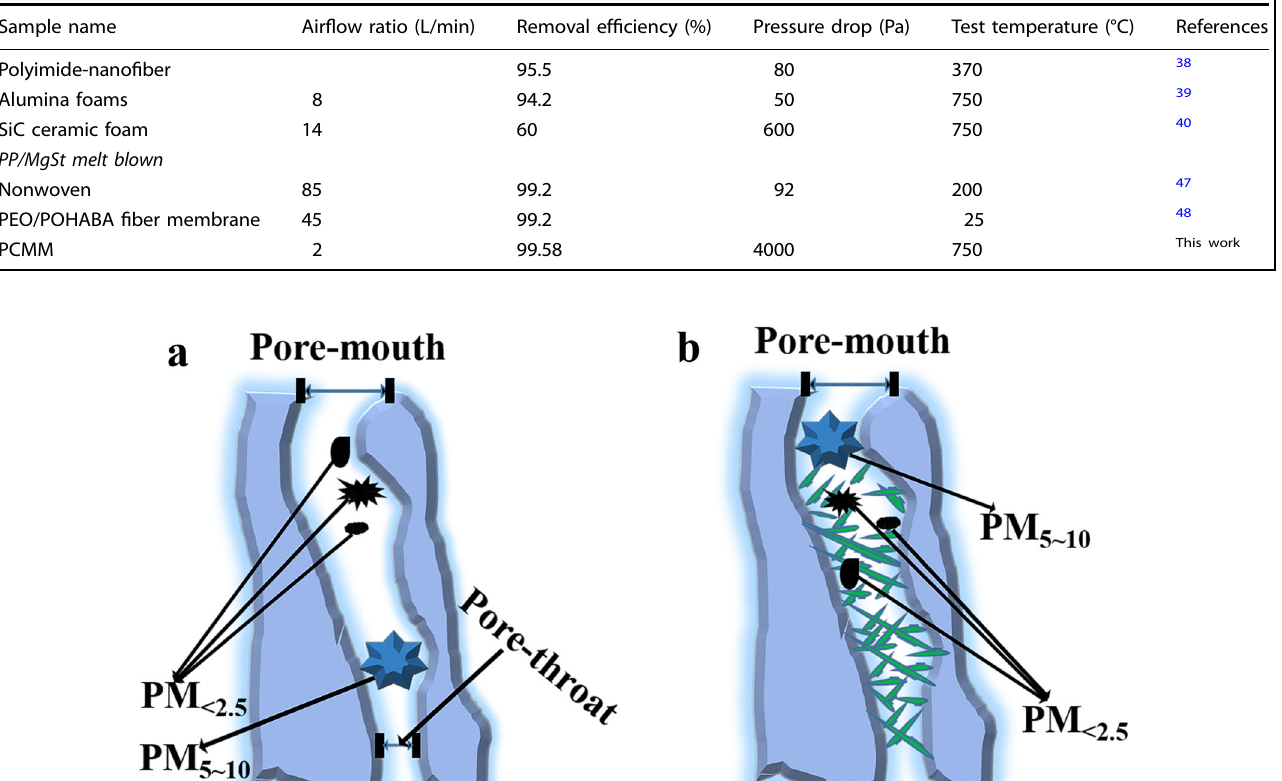
Table 5. Comparison of PM >2.5 μ m removal performance of PCMM with reported